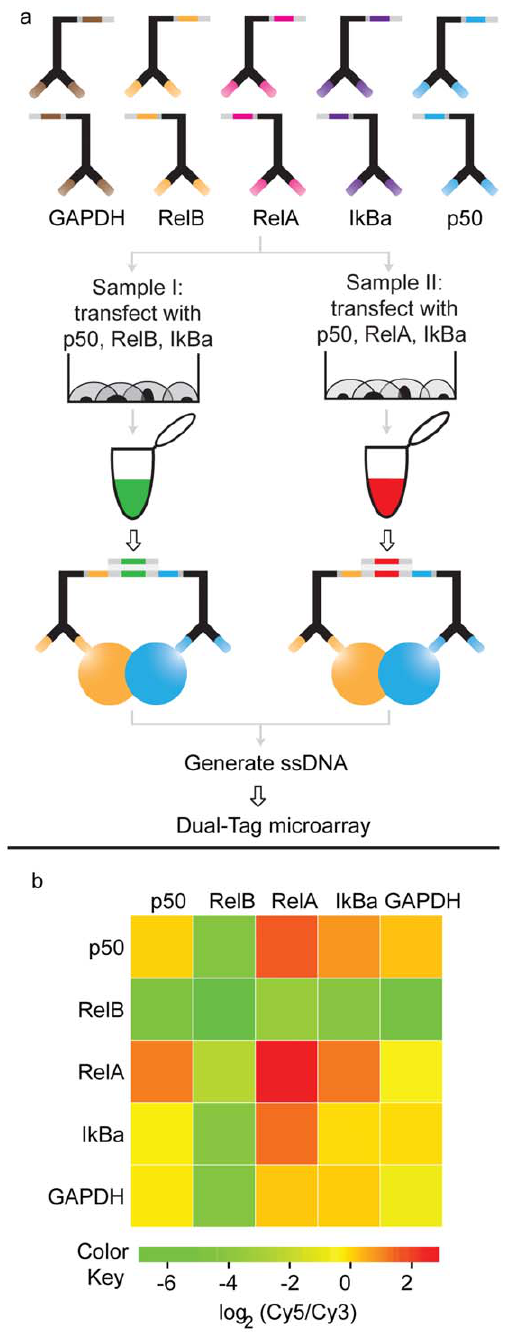
Figure 3. Detection of p50, RelA, RelB, I k B a and GAPDH, and any pairwise interactions in cell lysates. a ) Cells were transfected with genes encoding proteins of the NF k B family; either p50, I k B a and RelB (sample I); or p50, I k B a and RelA (sample II). The two populations of cells were lysed and the PLA probes were added to the cell lysates in separate reactions. After generating the reporter molecules by ligation, the two samples were pooled to amplify the ligation products by PCR, followed by readout via DTM. b ) The results are represented in a heat map where negative log 2 Cy5/Cy3 ratios (color coded as more green) indicate a higher abundance of proteins or protein interactions in sample I than in sample II, while positive log 2 Cy5/Cy3 ratios (color coded as more red) indicate the opposite